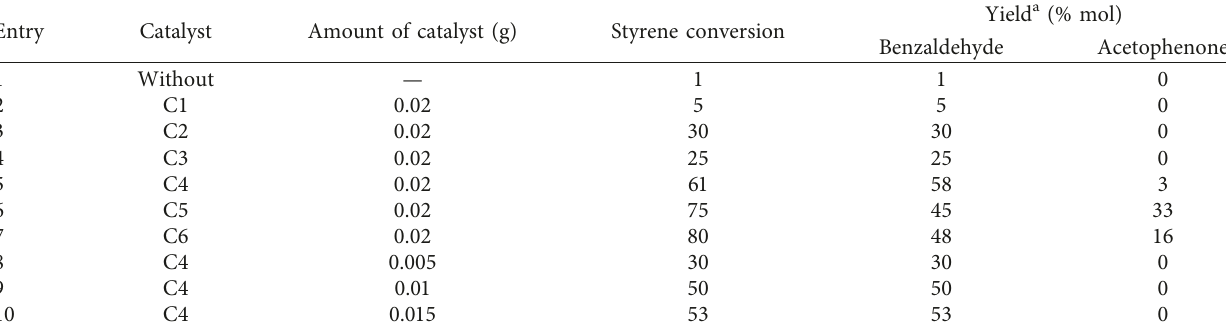
Table 2: Effect of the catalyst’s amount and loading.